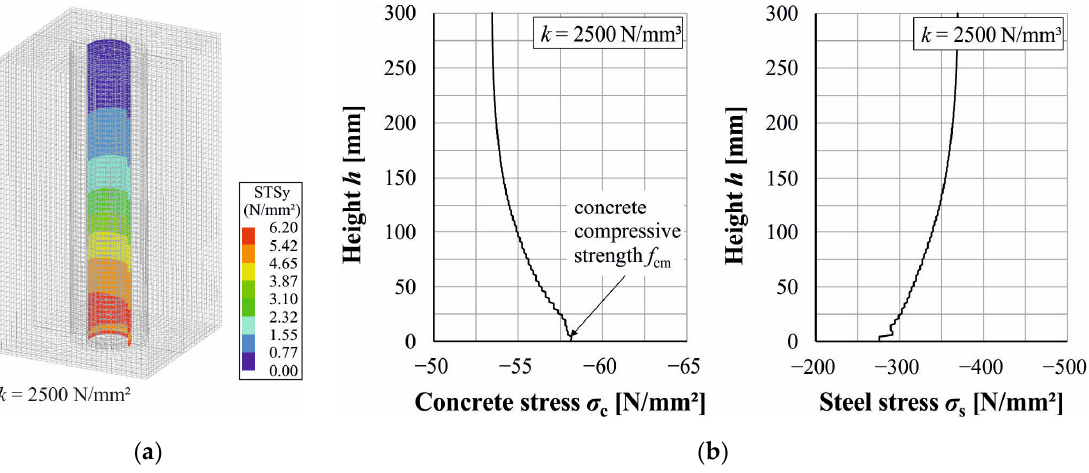
Figure 15. Evaluation of stresses: ( a ) bond stresses in the interface; ( b ) development of concrete and steel stresses over the height.